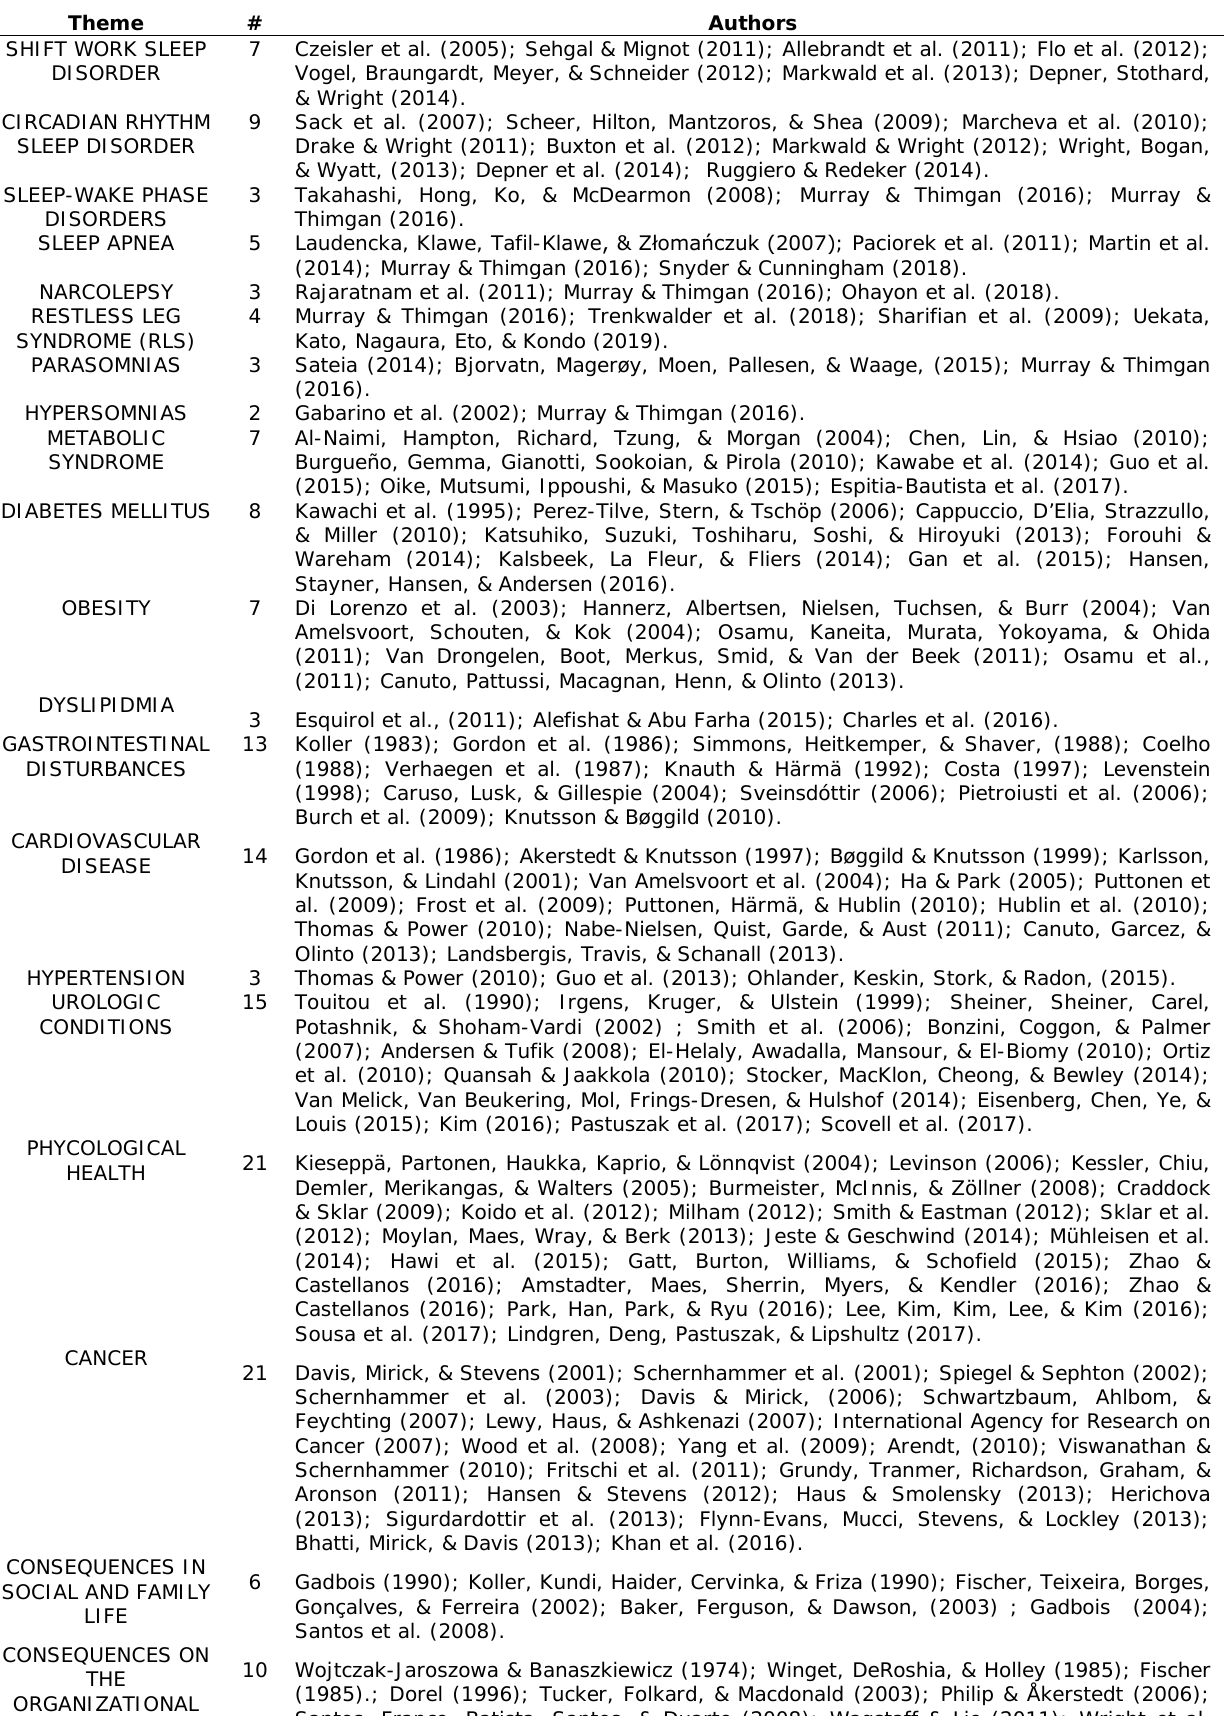
Table 2. Articles used to perform this